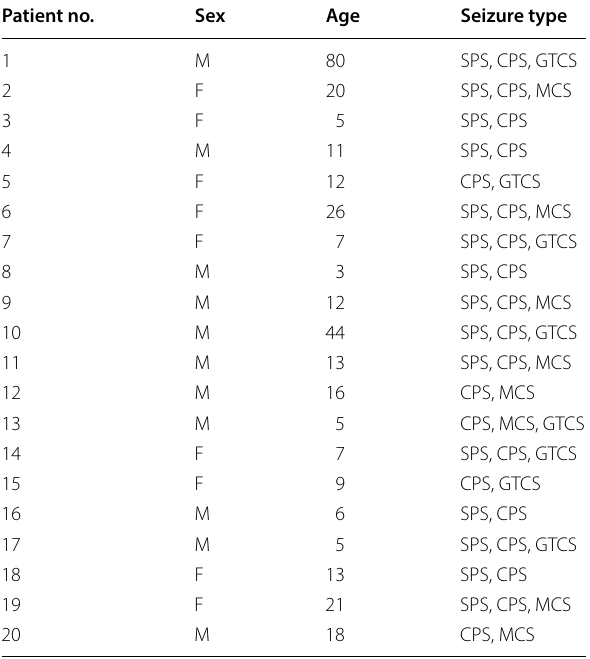
Table 1 Information of each patient EEG data used in our